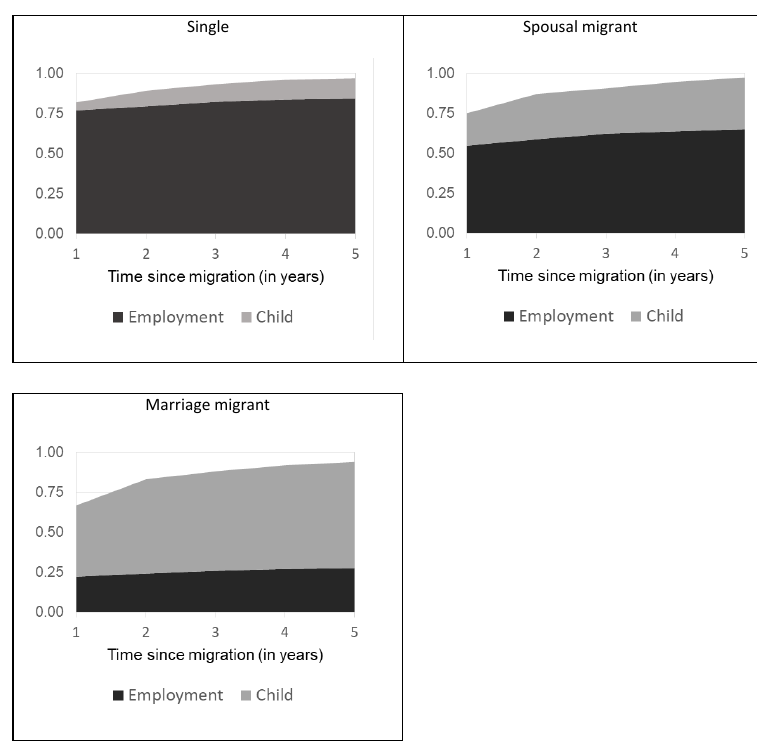
Figure 2 : Competing risks “employment” or “childbirth” after migration, cumulated incidence curves Single Spousal migrant